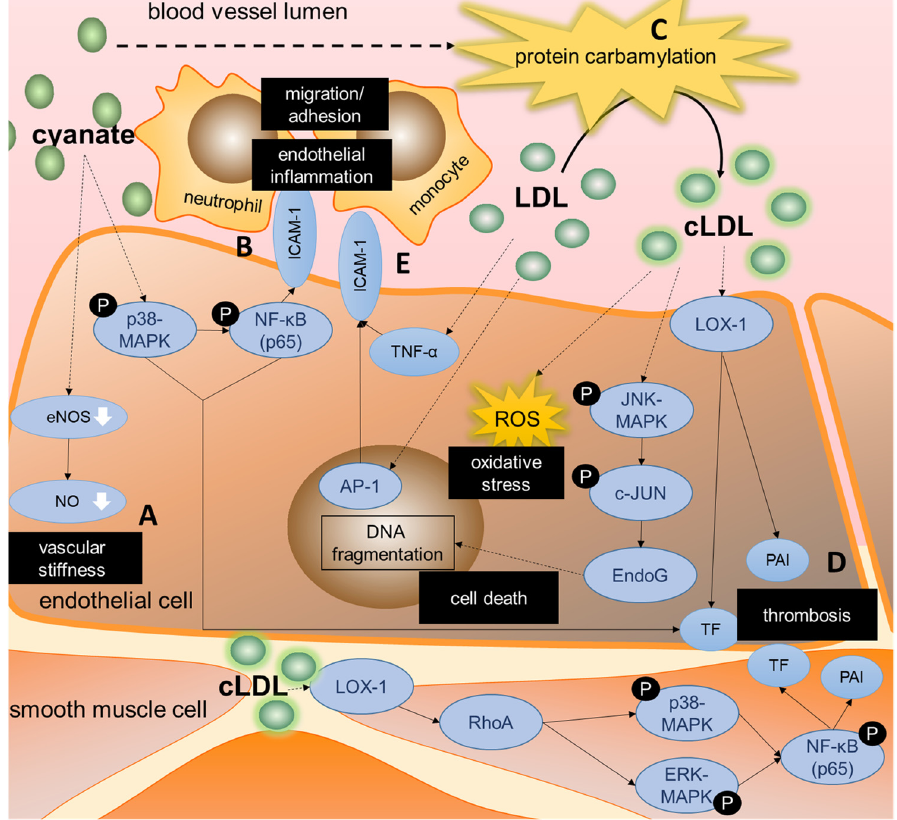
Figure 4. Mechanisms underlying cyanate or (modified) LDL-induced endothelial dysfunction. Increased cyanate levels as in CKD patients induce cellular signaling triggering endothelial dysfunction as displayed in increased vascular stiffness ( A ) as well as enhanced endothelial inflammation, triggering the recruitment and adhesion of inflammatory cells ( B ). Furthermore, cyanate-induced protein carbamylation leads to carbamylated low-density lipoprotein (cLDL), which can trigger oxidative stress and cell death ( C ) and can increase thrombotic risk through increases in tissue factor and PAI ( D ). In addition, LDL was shown to contribute to endothelial inflammation by upregulating pro-inflammatory cytokines and adhesion molecules, triggering inflammatory cell recruitment and adhesion ( E ). AP-1 = activator protein-1; cLDL = carbamylated LDL; EndoG = endonuclease G; eNOS = endothelial nitric oxide synthase; ICAM = intracellular adhesion molecule; LDL = low density lipoprotein; LOX-1 = Lectin-like oxidized low density lipoprotein receptor-1; MAPK = mitogen activated protein kinase; NF-kB = nuclear factor kappa B; NO = nitric oxide; PAI = plasminogen activator inhibitor; TF = tissue factor; TNF = tumor necrosis